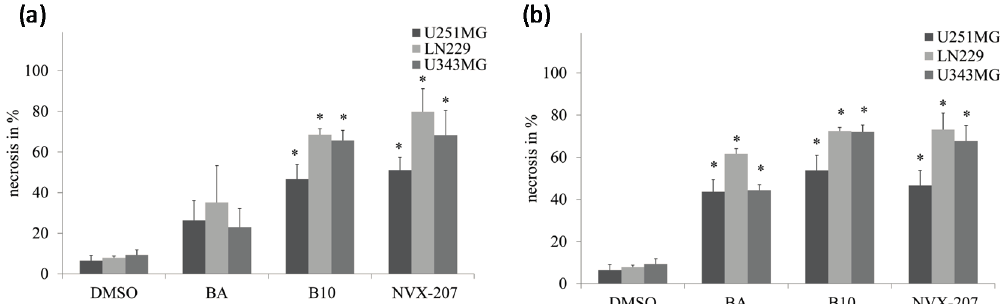
Figure 5. Effects of 20 ( a ) and 30 µM ( b ) BA, B10 or NVX-207 on necrosis of glioma cell lines were determined using the LDH assay. The data represent the mean values (±SD) of three independent experiments. Significant differences between BA and BA derivatives were labeled (* p <